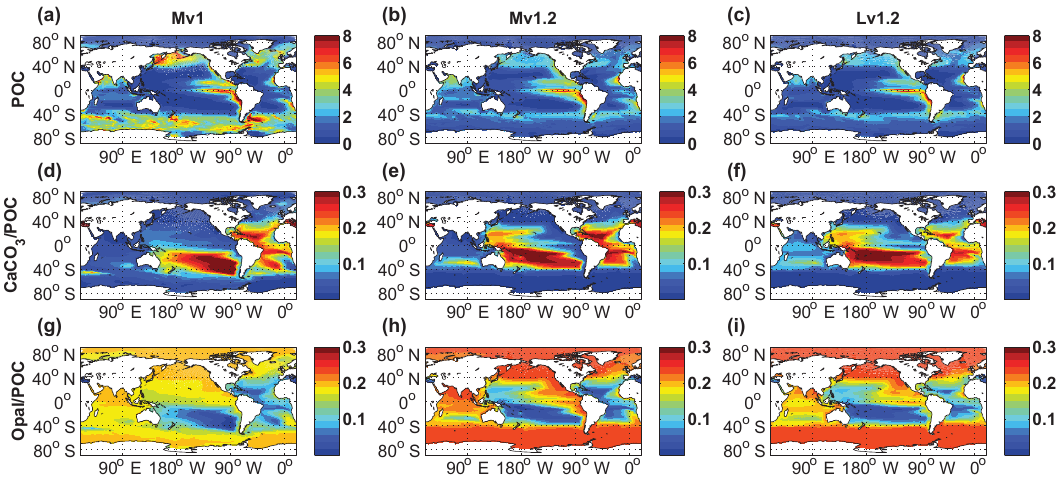
Figure 9. Export production of POC averaged over the years 2003–2012 for the model configurations (a) Mv1, (b) Mv1.2, and (c) Lv1.2; corresponding CaCO 3 to organic carbon ratio in exported matter for (d) Mv1, (e) Mv1.2, and (f) Lv1.2; corresponding opal to organic carbon ratio in exported matter for (g) Mv1, (h) Mv1.2, and (i) Lv1.2.